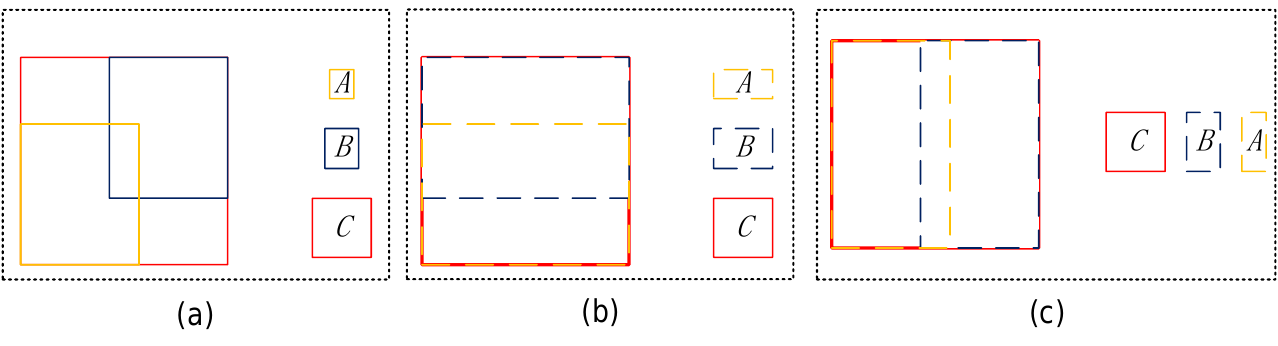
Figure 3. Three different relationships between the predicted box A , ground truth box B , and their minimum circumscribed rectangle C : ( a ) inclusive relationship; ( b ) same-width relationship; ( c ) same-height relationship.